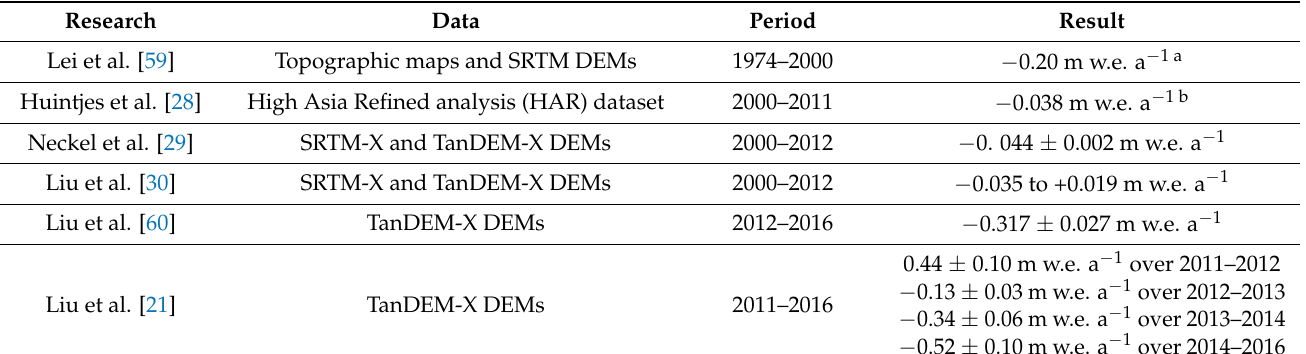
Table 3. A comparison of our study to previous studies on the glacier mass balance of the Puruogangri Ice